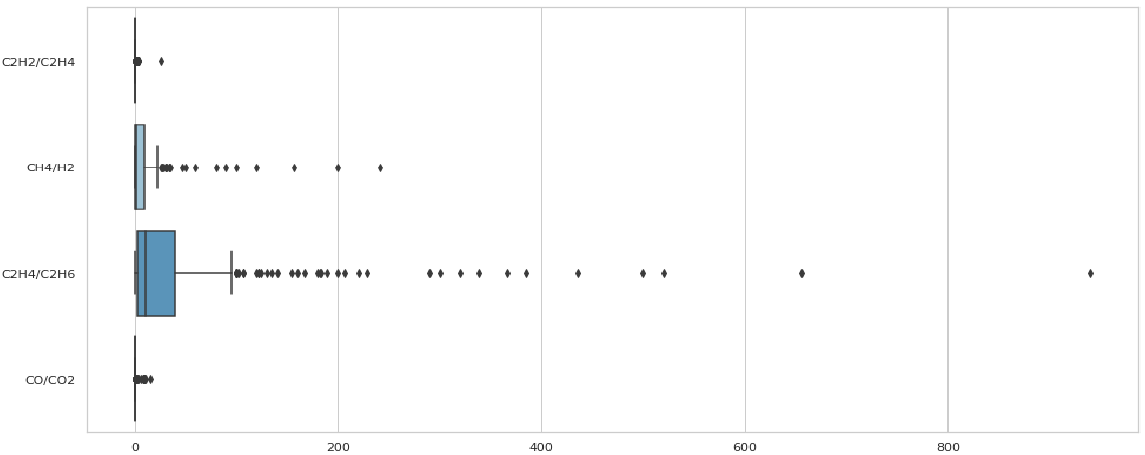
Figure 11. Box plot of ratios of the dissolved gas concentrations.